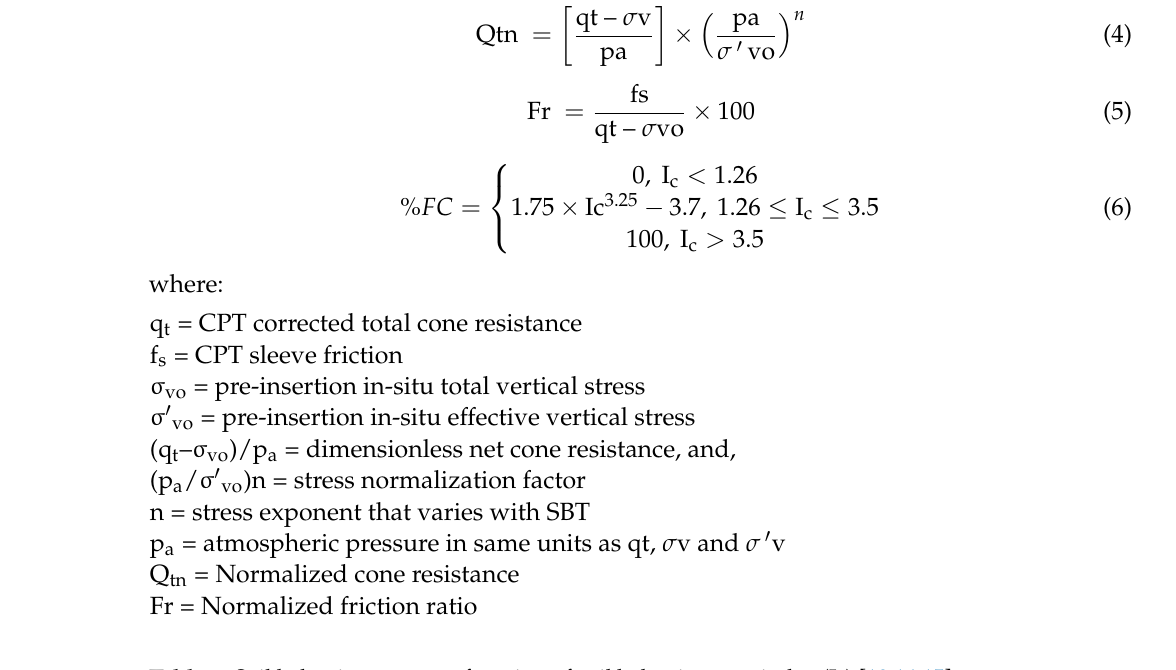
Table 1. Soil behavior type as a function of soil behavior type index (I c ) [10,14,15]. Zone Soil Behavior Type I c 1 Sensitive, fine grained N/A 2 Organic soils—clay >3.6